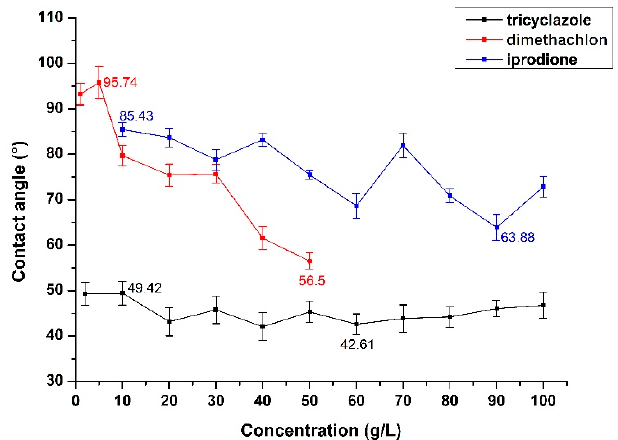
Figure 9. The variation of contact angle with the variation of PPP concentration.